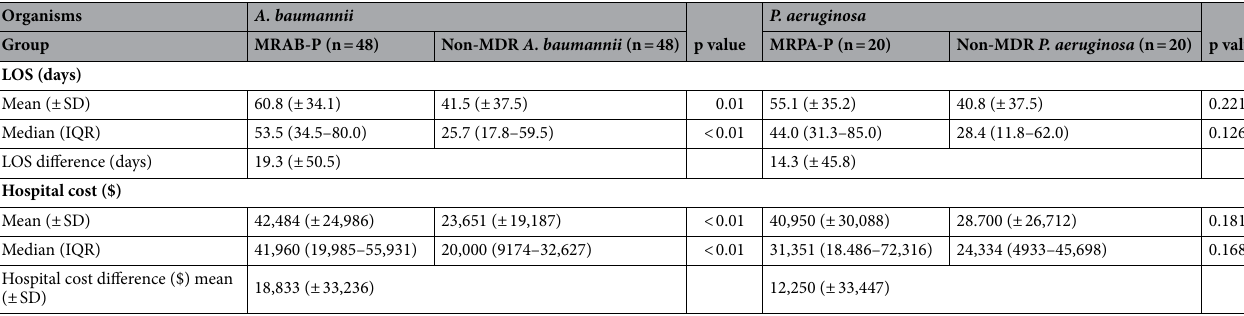
Table 2. Differences in costs and lengths of hospital stay between patients with multidrug-resistant (MDR) and non-MDR bacterial pneumonia. MRAB-P multidrug resistant A. baumannii pneumonia, MDR multidrug- resistant, MRPA-P multidrug resistant P. aeruginosa pneumonia, LOS length of stay, IQR interquartile range, SD standard deviation.